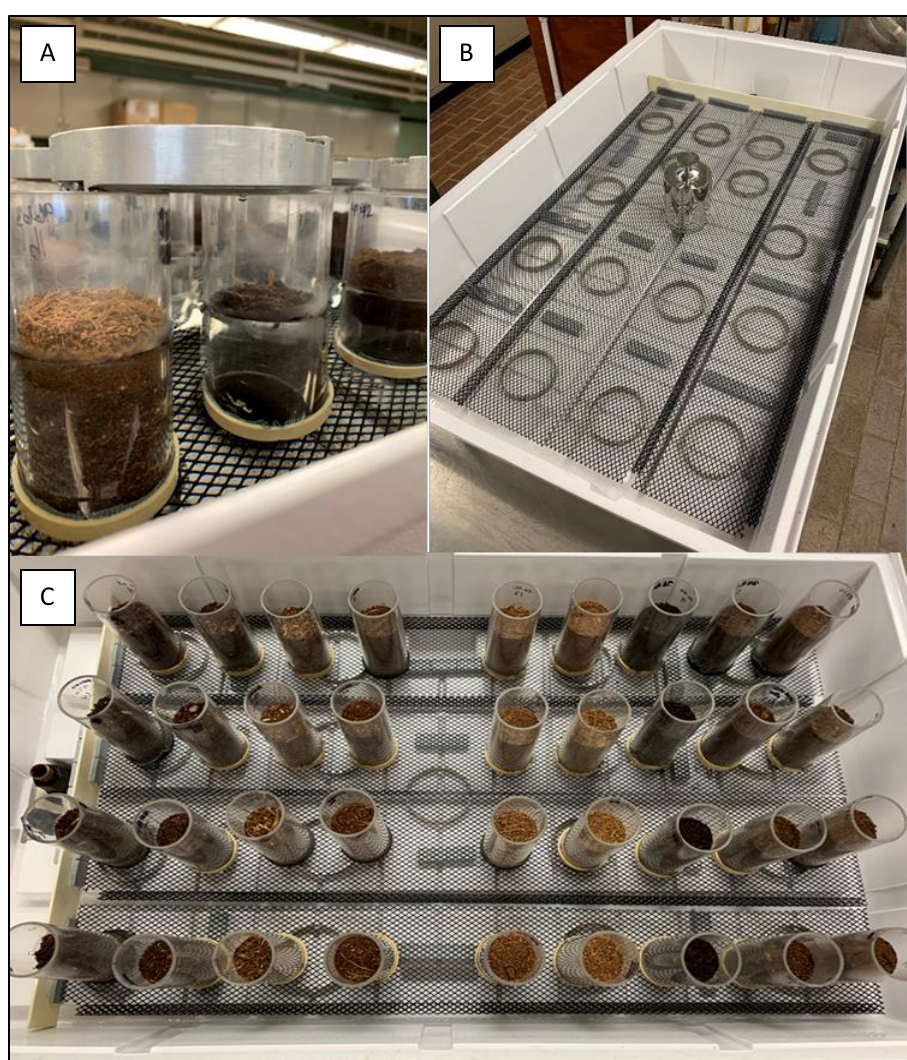
Figure 3. Ebb and flood subirrigation system. ( A ) Container capacity testing with 2 kg aluminum weights. ( B ) Partially constructed ebb and flood unit with aluminum rings with mesh screen. ( C ) Fully constructed system complete with packed substrate cylinders.